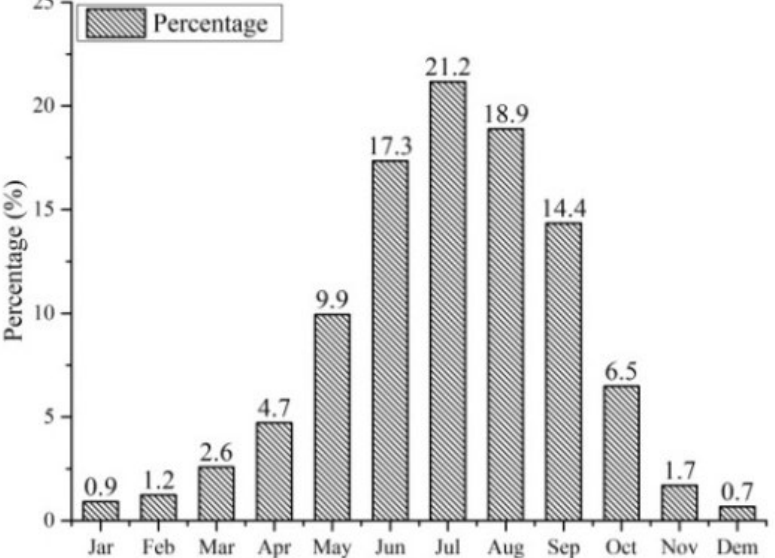
Figure 3. Yearly cycles in annual precipitation percentage (%) in the TP and TPS.